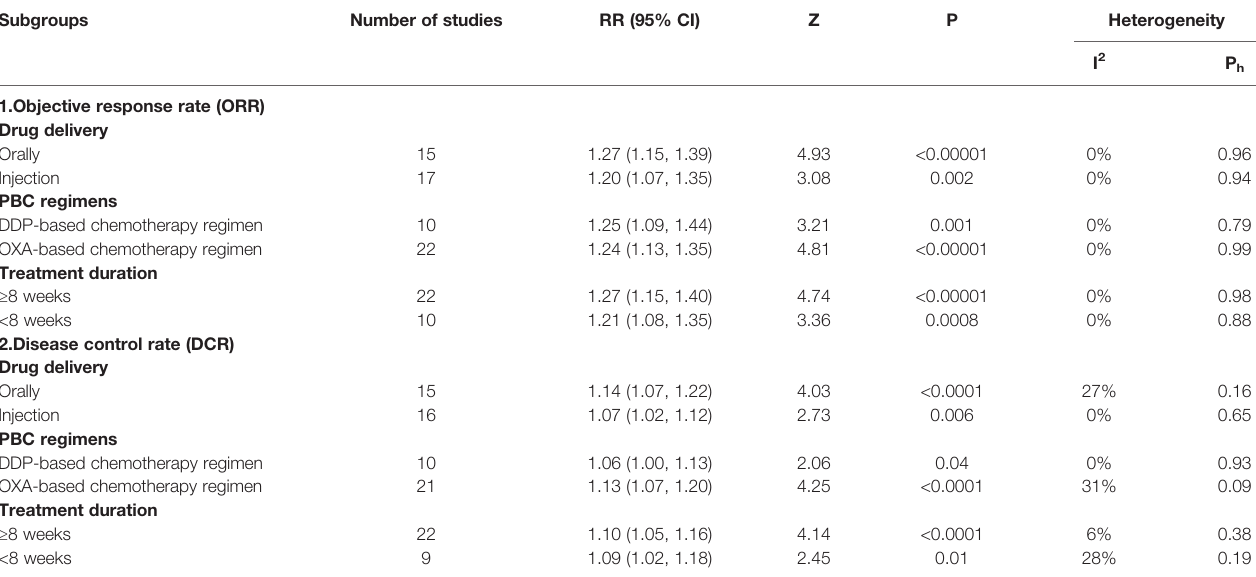
TABLE 3 | Subgroup analysis of ORR and